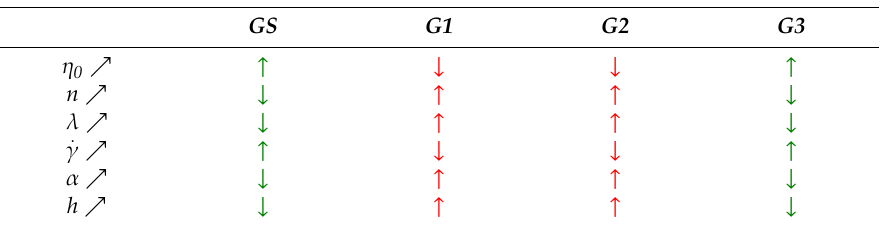
Table 2. Simulation summary (green - I m > 0 , red - I m < 0 ). E ff ect of Process Parameters and Runners Layout on Filling Imbalance –